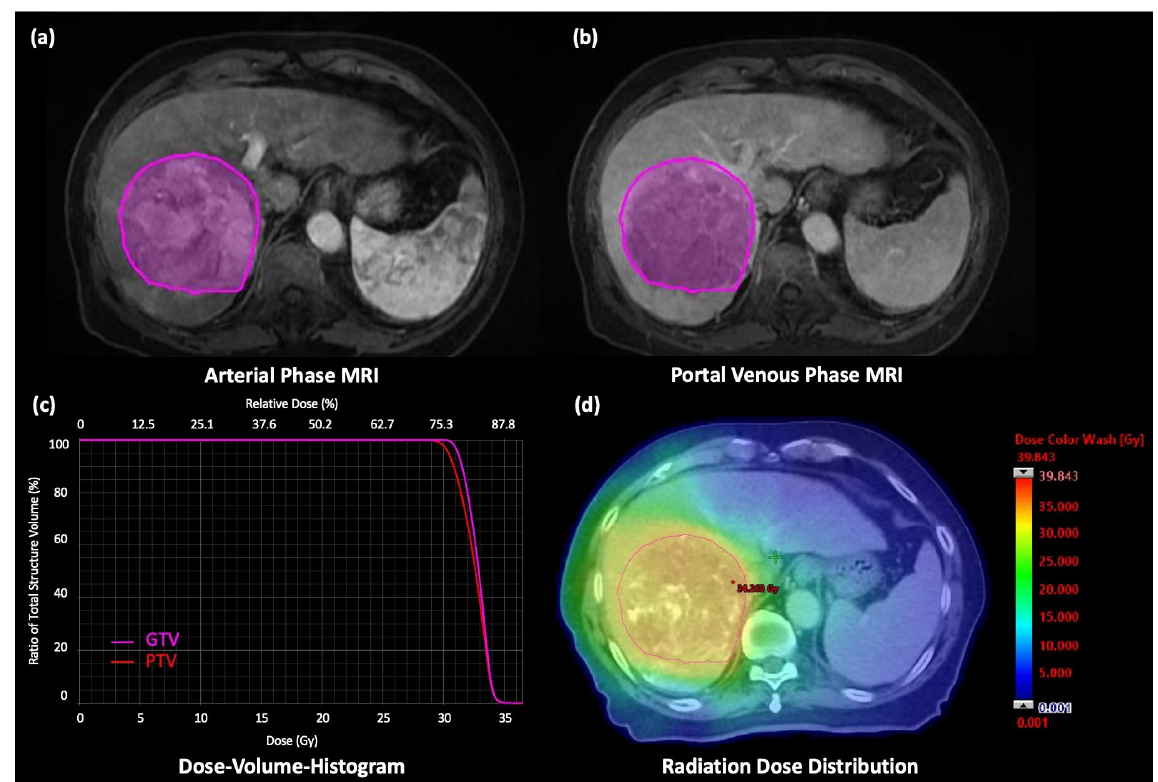
Figure 1. A 76-year-old male patient was diagnosed with advanced-staged HCC. ( a ) Axial AP T1W MR image with the VOI, ( b ) Axial PVP T1W MR image with the VOI. SBRT of 30 Gy was prescribed in 5 fractions to the tumor. ( c ) DVH of gross tumor volume (GTV) and planning target volume (PTV) generated from the treatment planning system and ( d ) Dose distribution of the SBRT treatment plan.